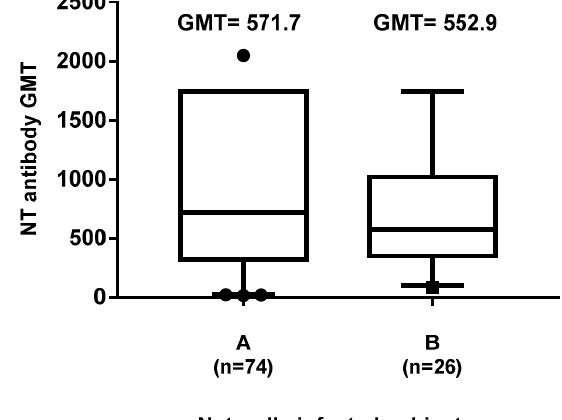
Figure 7. Differences in neutralizing antibody titers in naturally infected subjects born before (A) and after (B) 1977 (one year after the introduction of measles vaccine in Italy). The whiskers represent the values from the 5th to the 95th percentiles; the median, the 25th and 75th percentiles are depicted by the horizontal lines in the boxes. Individual data points are shown; outlier values are shown as black circles or squares. GMTs are shown above the population columns. Difference in GMT between the two groups is not significant ( p > 0.05).